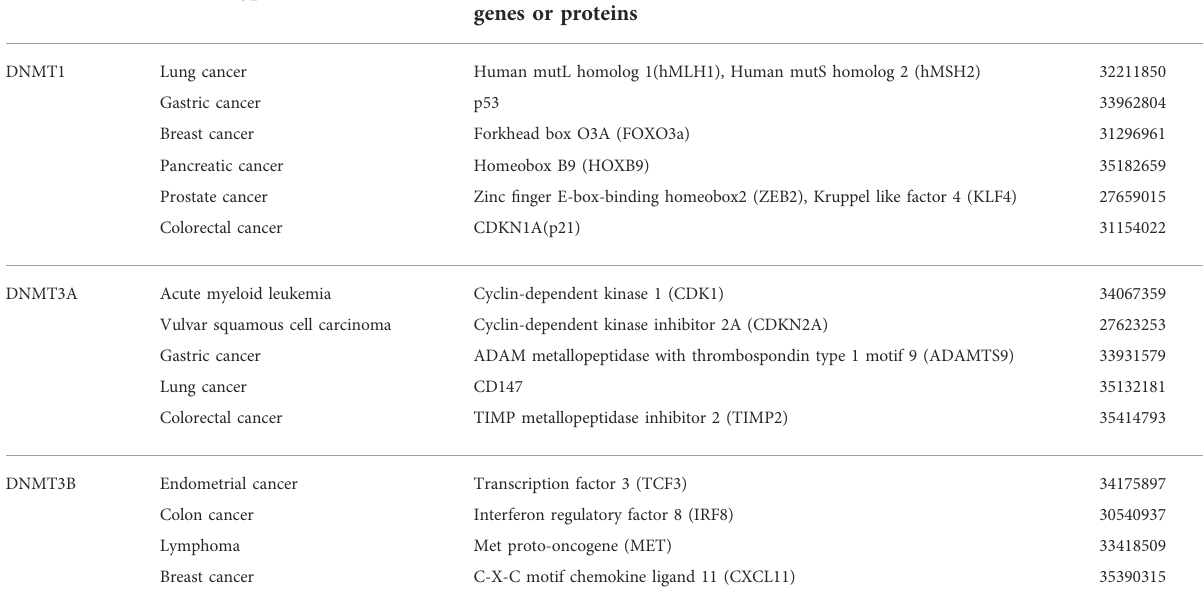
TABLE 2 Downstream genes or proteins of DNMTs in